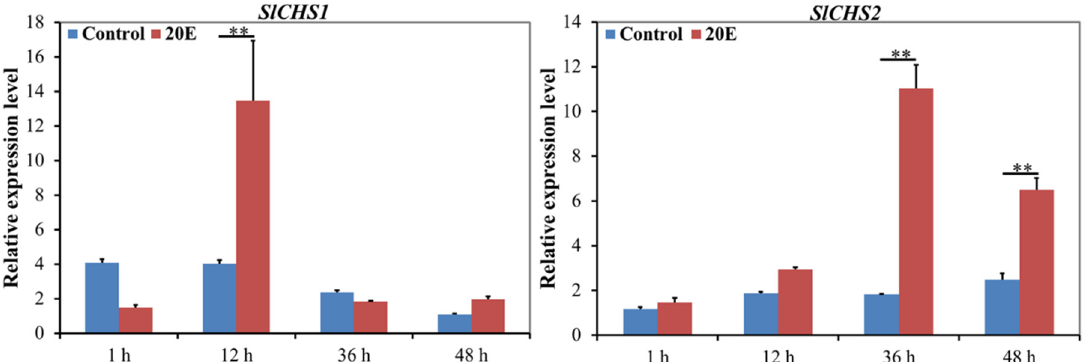
Figure 4. Expression levels of SlCHS1 and SlCHS2 after 20E treatment in S. litura . Data were normalized using glyceraldehyde-3-phosphate dehydrogenase ( GAPDH ) and are represented as the means ± standard errors of the means from three independent experiments. Relative expression levels were calculated using the 2 - ∆∆ Ct method. Statistical analysis was performed using SPSS software. All data were analyzed using ANOVA and Tukey’s test. Significant differences are indicated by ** ( p < 0.01).